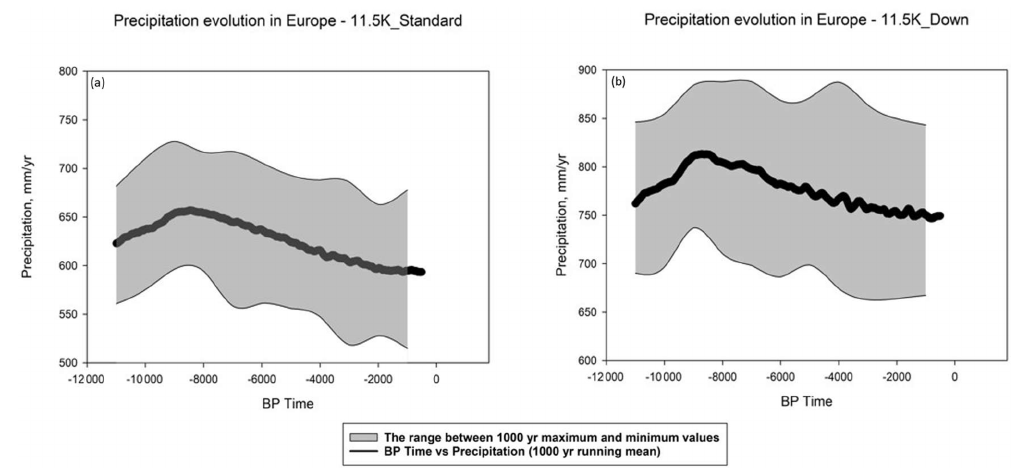
Figure 5. Annual precipitation evolution in Europe during the Holocene for both 11.5K_Standard (a) and 11.5K_Down (b) . Grey-shaded areas represent the range between the maximum and minimum precipitation values in the transient simulations, and the black curve shows the 1000-year running mean of precipitation (in mmyr − 1